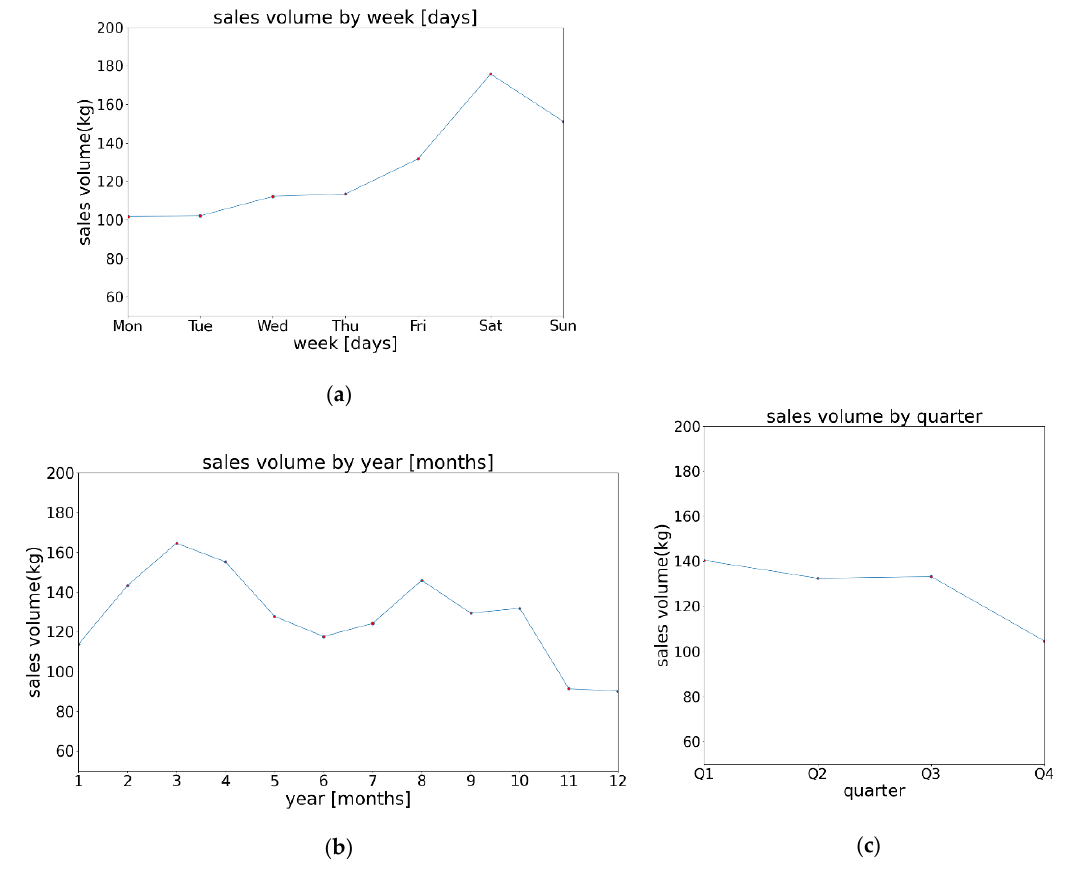
Figure 4. Average sales of lettuce data by day, month, and quarter. ( a ) Average sales by day of week, ( b ) average sales by month, and ( c ) average by quarter.